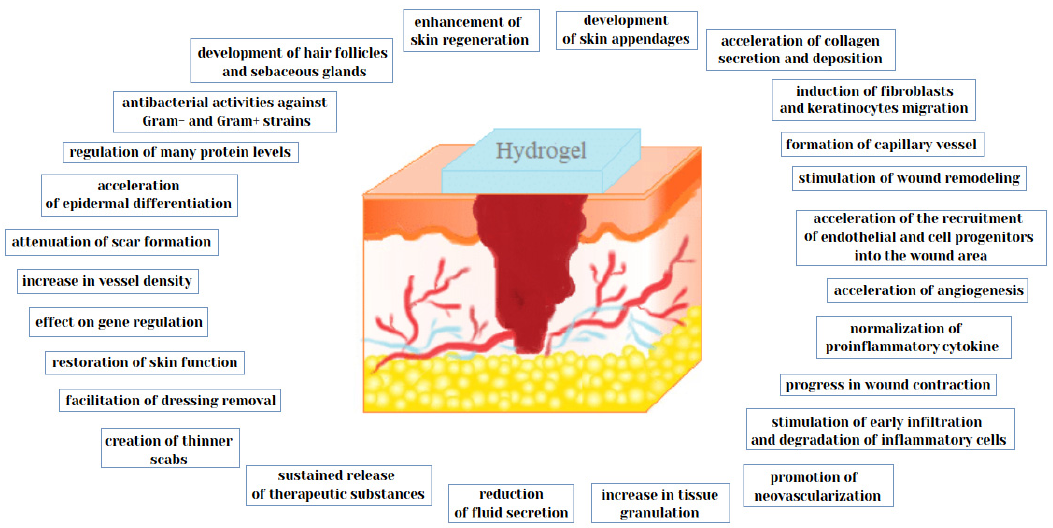
Figure 2. The e ff ect of hydrogels on the wound healing Figure 2. The effect of hydrogels on the wound healing process.